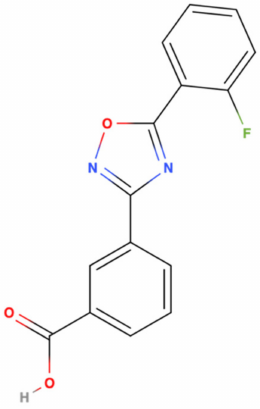
Figure 1. Two-dimensional (2D) structure of ataluren generated using MolView software. The main structural parts are 1,2,4-oxadiazole ring (middle one) connected to fluorobenzene (on the right-hand side) and benzoic acid (on the bottom left-hand side)